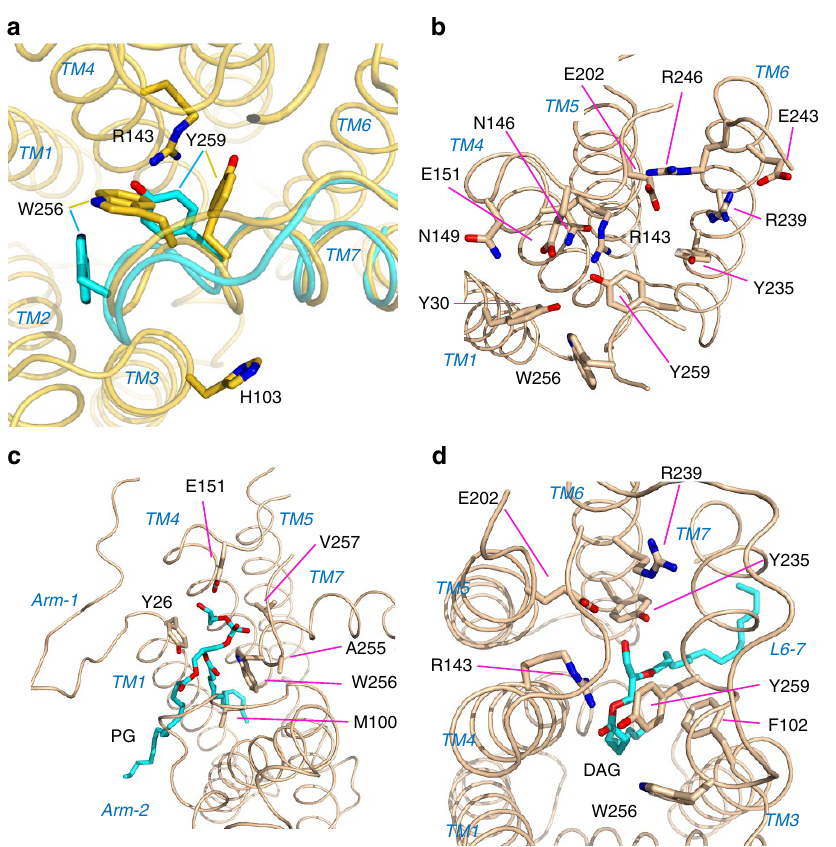
Figure 3 | Structural features. ( a ) Conformational change around L6–7 between the two crystal forms. The form-1 structure (1.6Å resolution) is shown in yellow, and form-2 (1.9Å) in cyan. Only the loop L6–7 region shows significant conformational change, including sidechain rearrangement. This conformational change is hypothesized to be part of the transfer mechanism of the substrate PG from the first binding site to the second one. ( b ) Buried H-bond network. ( c ) PG-1 binding site. Backbone of PG is coloured in cyan. ( d ) DAG-2 binding site. The backbone of DAG is coloured in